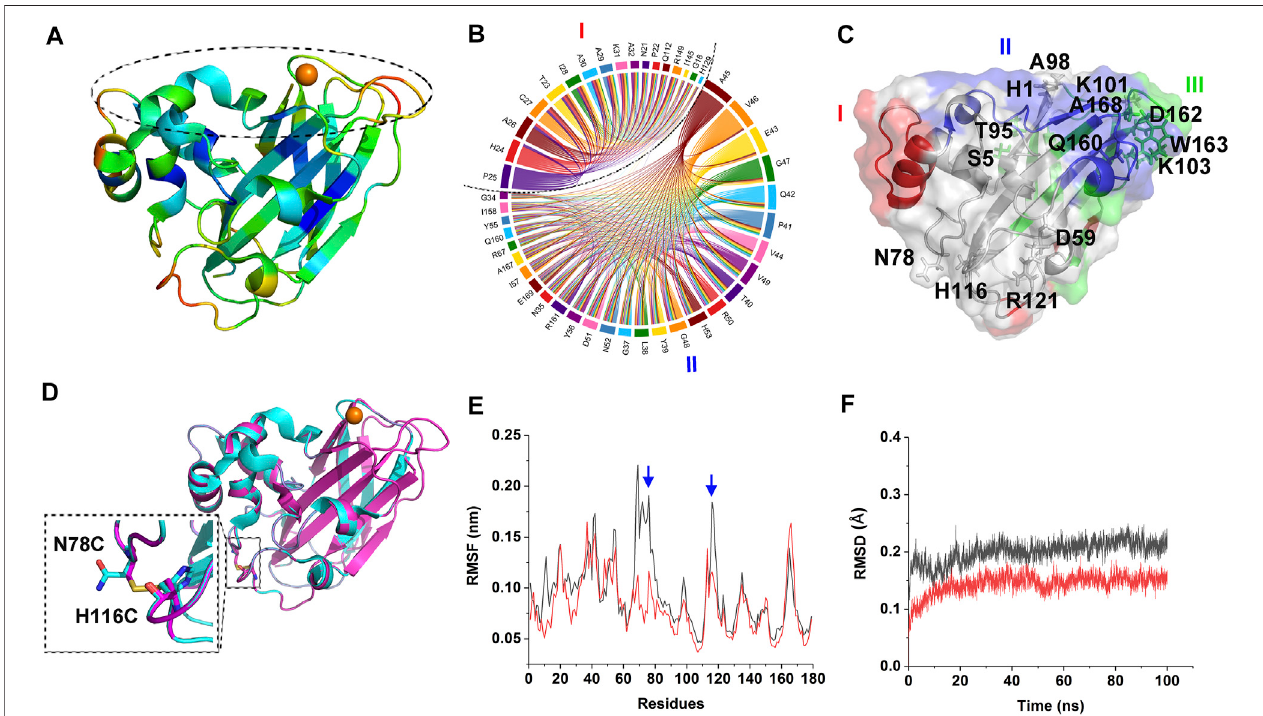
FIGURE 1 | Design of the mutant. (A) Structure of CjLPMO10A cd . The color from blue to red indicates the B-factor is from low to high. The dashed circle indicates the substrate-binding surface. (B) The top two coevolutionary groups from amino acid coevolution analysis of LPMO10s. (C) The three coevolutionary residues groups are mapped to the tertiary structure of CjLPMO10A cd (PDB ID: 5FJQ), colored by red, blue and green, respectively. The sites suggested by B-factor and DbD2 analysis areshowninsticksandlabeled. (D) SuperpositionofthemodelstructureofM1(N78C/H116C)andthestructureofCjLPMO10A cd .Cyan,CjLPMO10A cd ;magenta, M1. The enlarged dashed box shows the introduced disul fi de bond. The mutated sites are labeled and shown in sticks. (E) and (F) RMSF and RMSD of the 100 ns MD simulations of CjLPMO10A cd (black) and M1 (red). The blue arrows indicate the mutated